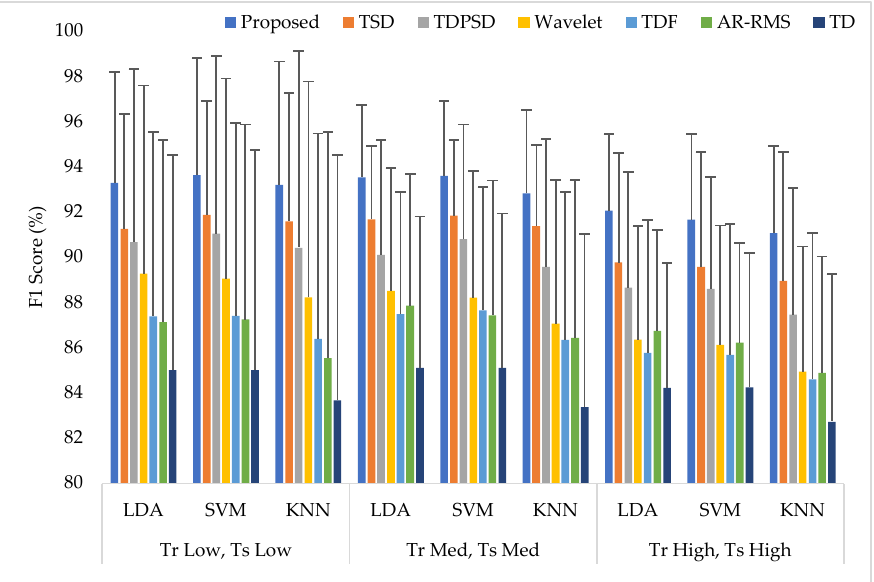
Figure 6. The EMG pattern recognition performances when the training and testing forces are the same, where Tr and Ts indicate training and testing, respectively.